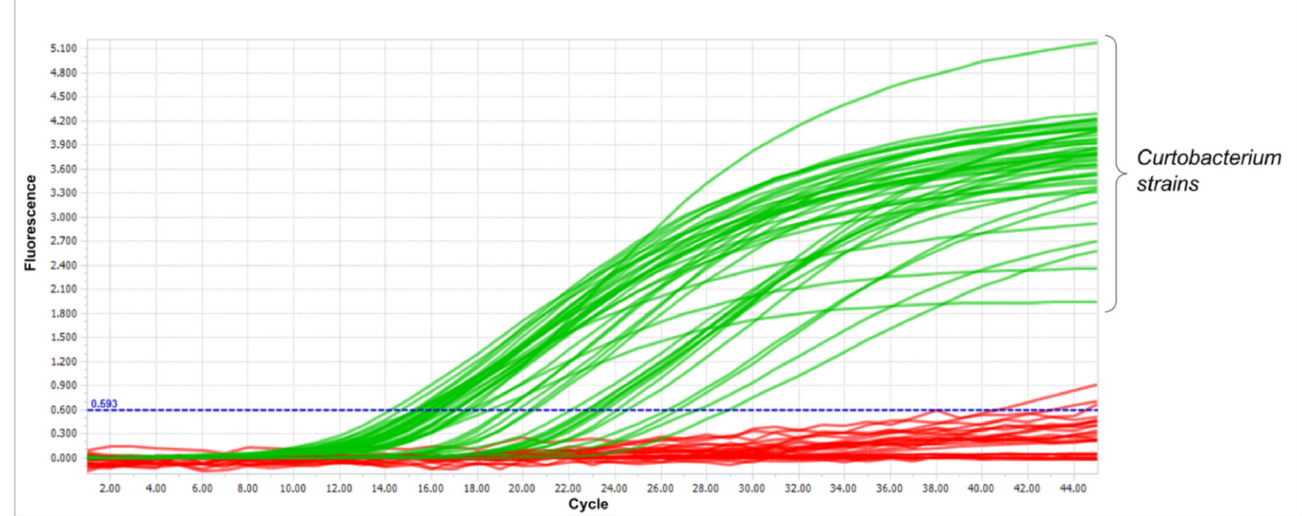
Figure 9. Amplification curves were obtained from the experiment to assess the selectivity of qPCR. The Curtobacterium strains are marked in green. Strains of other genera are marked in red.